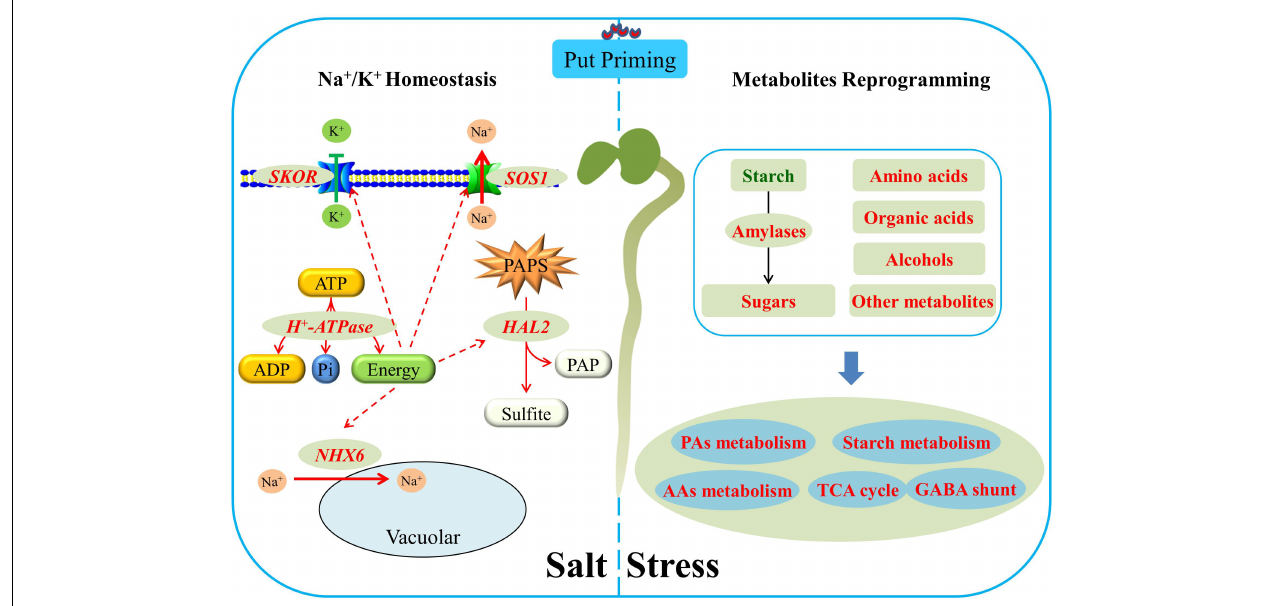
FIGURE 9 | Integrative pathways regulated by the Put priming during white clover seeds germination under salt stress. Red or green letters mean a significant increase or decrease,